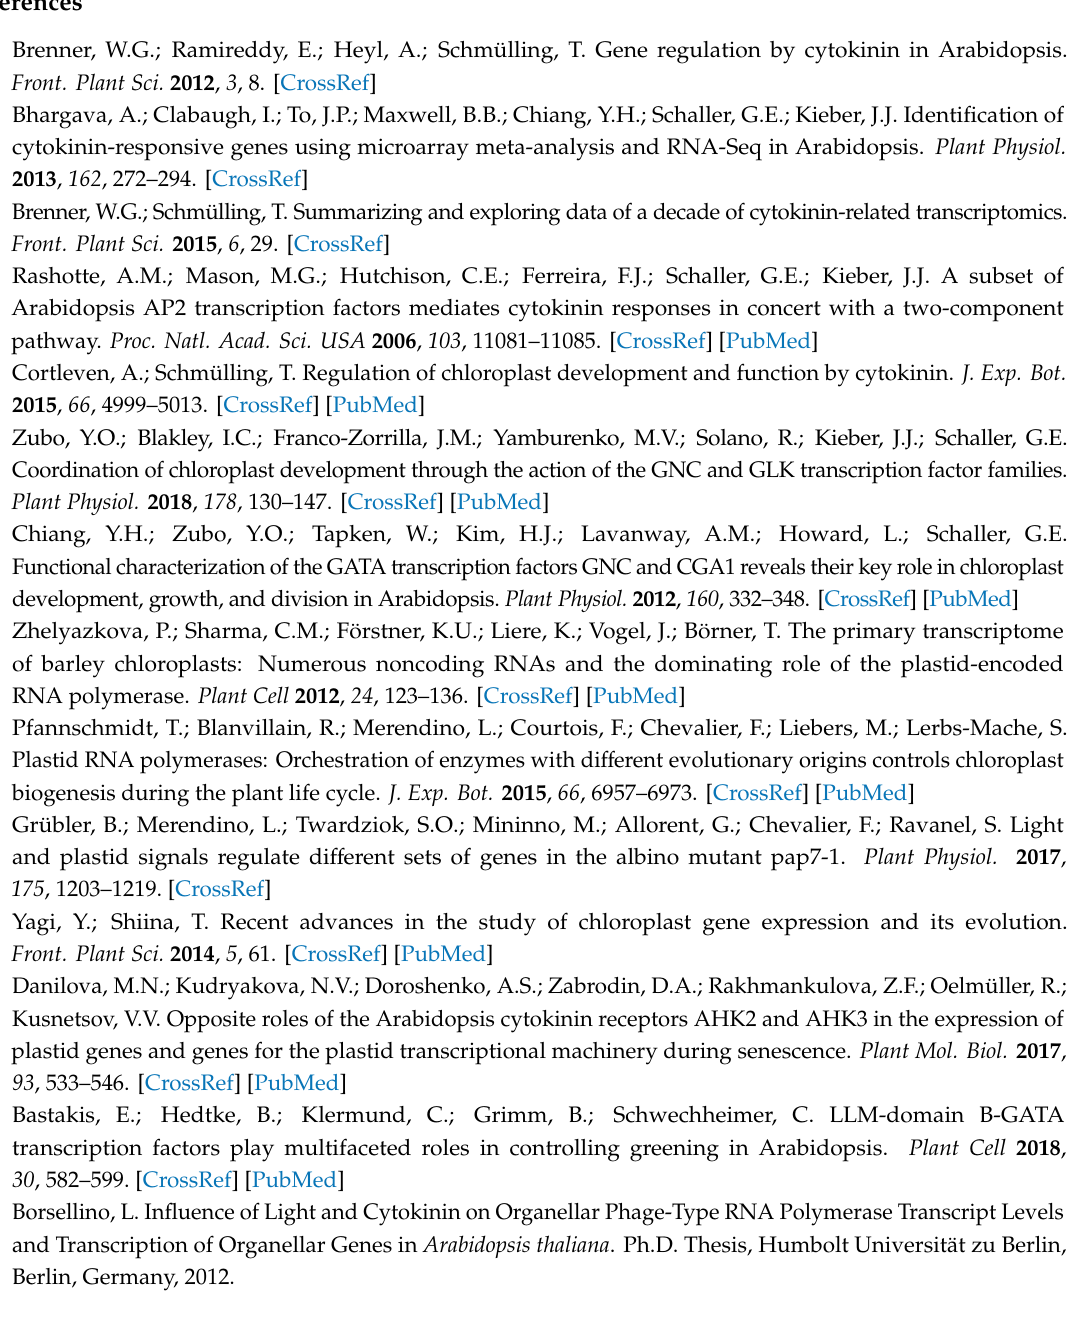
Figure S1: Immunoblot analysis of the photosynthetic proteins, Table S1: Primers sequences used in this study for qRT-PCR; Table S2: List of CK-related transcription factors identified in promoters of Pap genes using AthaMap